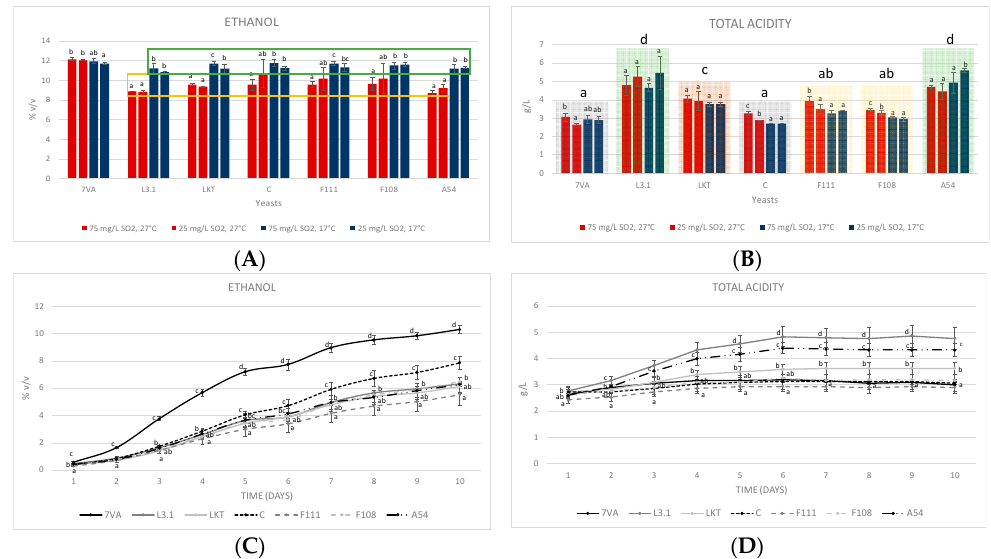
Figure 2. ( A ) Ethanol produced (measured by FTIR) in the 10 mL fermentations at two temperatures (17 °C, blue bars, and 27 °C, red bars) and two SO 2 contents (25 and 75 mg/L). ( B ) Total acidity in the 10 mL test expressed as tartaric acid. ( C ) Accumulated ethanol formed in the 1 L test (17 °C and 50 mg/L of total SO 2 ). ( D ) Total acidity in the 1 L test. Values are means ± sd ( n = 3). Different letter for the same yeast means significant differences ( p < 0.05). In section b , the averages of each yeast were also statistically compared. The statistic, in section c and d, reading goes on the same day in the di ff erent